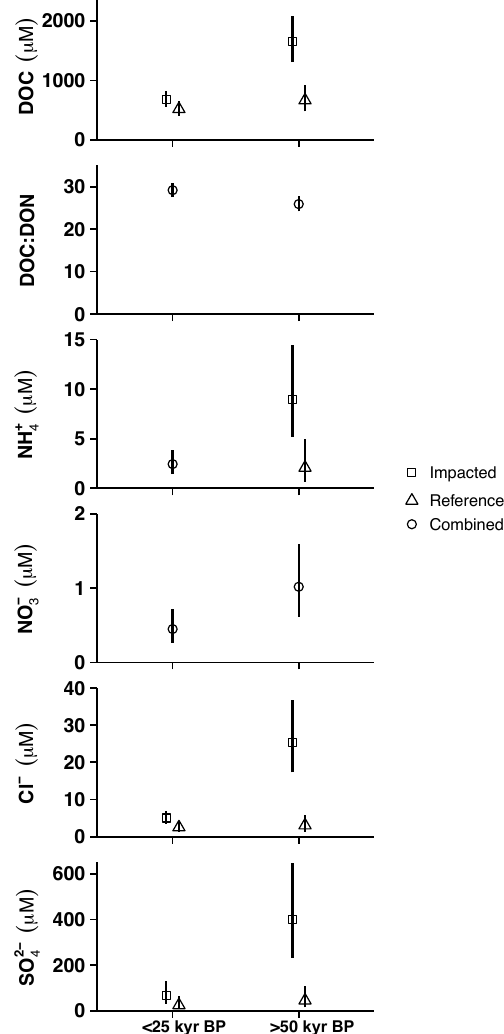
Figure 9. Mean ( ± 95% CI) of parameters that varied significantly by surface age. Impacted and reference concentrations are shown in- dependently when the interaction between thermokarst impact and surface age was significant, otherwise results are